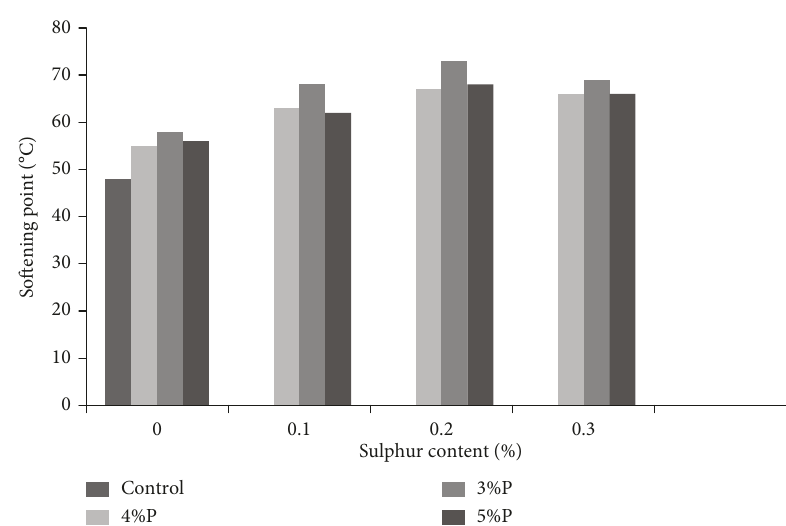
Figure 4: Softening point of base and modified bitumen.